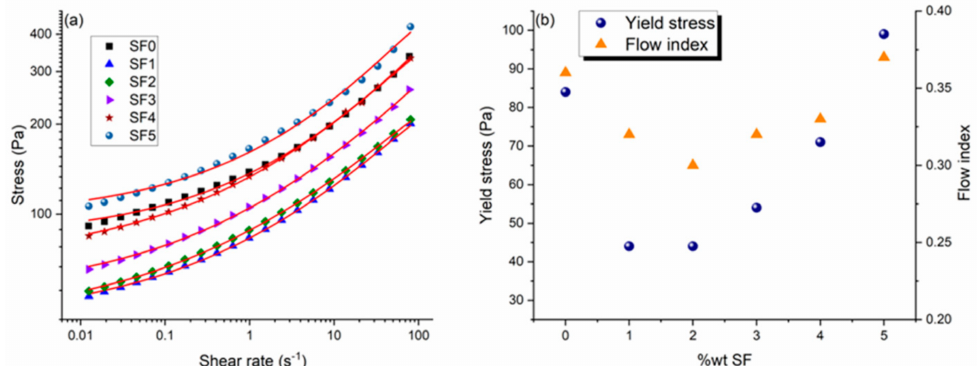
Figure 6. Influence of the surfactant concentration (0–5 wt.%) on the rheological properties of the CBR gel: ( a ) shear stress as a function shear rate with experimental data points and lines of best fit using the Herschel–Bulkley model. ( b ) Yield stress and flow index as a function of the surfactant concentration obtained from the fits using the Herschel–Bulkley